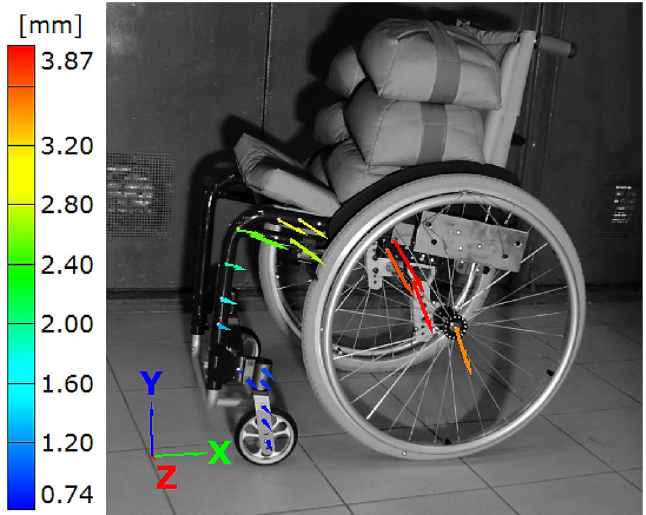
Figure 8. Distribution of the resultant vectors of deflection in the wheelchair loaded by the force of 1.5 kN from side view.